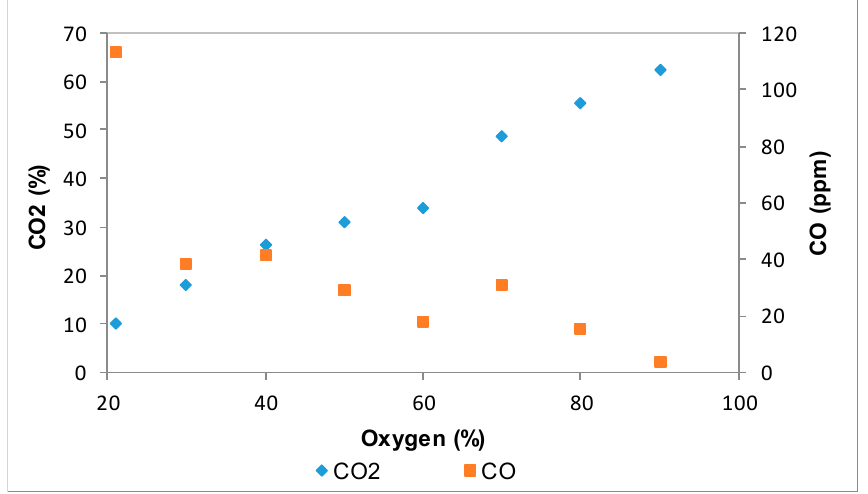
Figure 11. Effect of the oxygen enrichment on the emissions of CO 2 and CO.